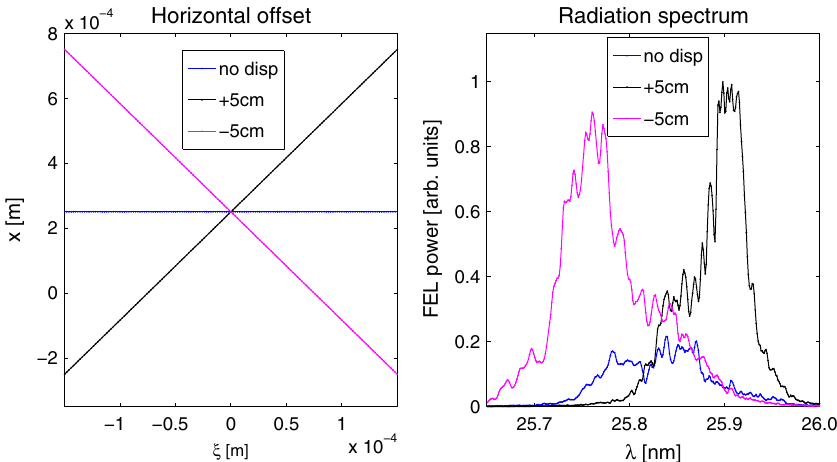
FIG. 12. (Color) Dispersion effects on the wavelength spectrum for an initial offset of 250 (cid:2) m along the bunch.